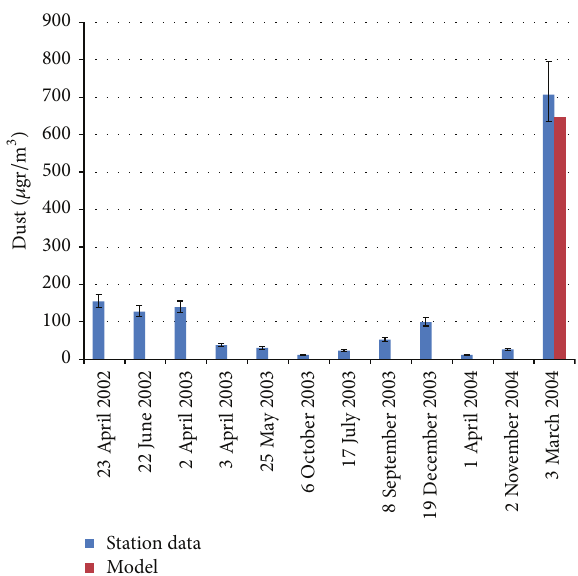
Figure 17: Concentration of Al in different dust episodes from Gran Canaria Stations converted to mineral dust concentration and compared with model simulation of dust deposition event of 3 March 2004.